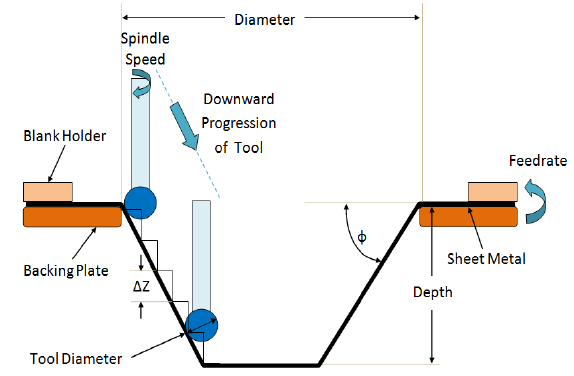
Fig. 1. Principle of the single point incremental forming process [3].